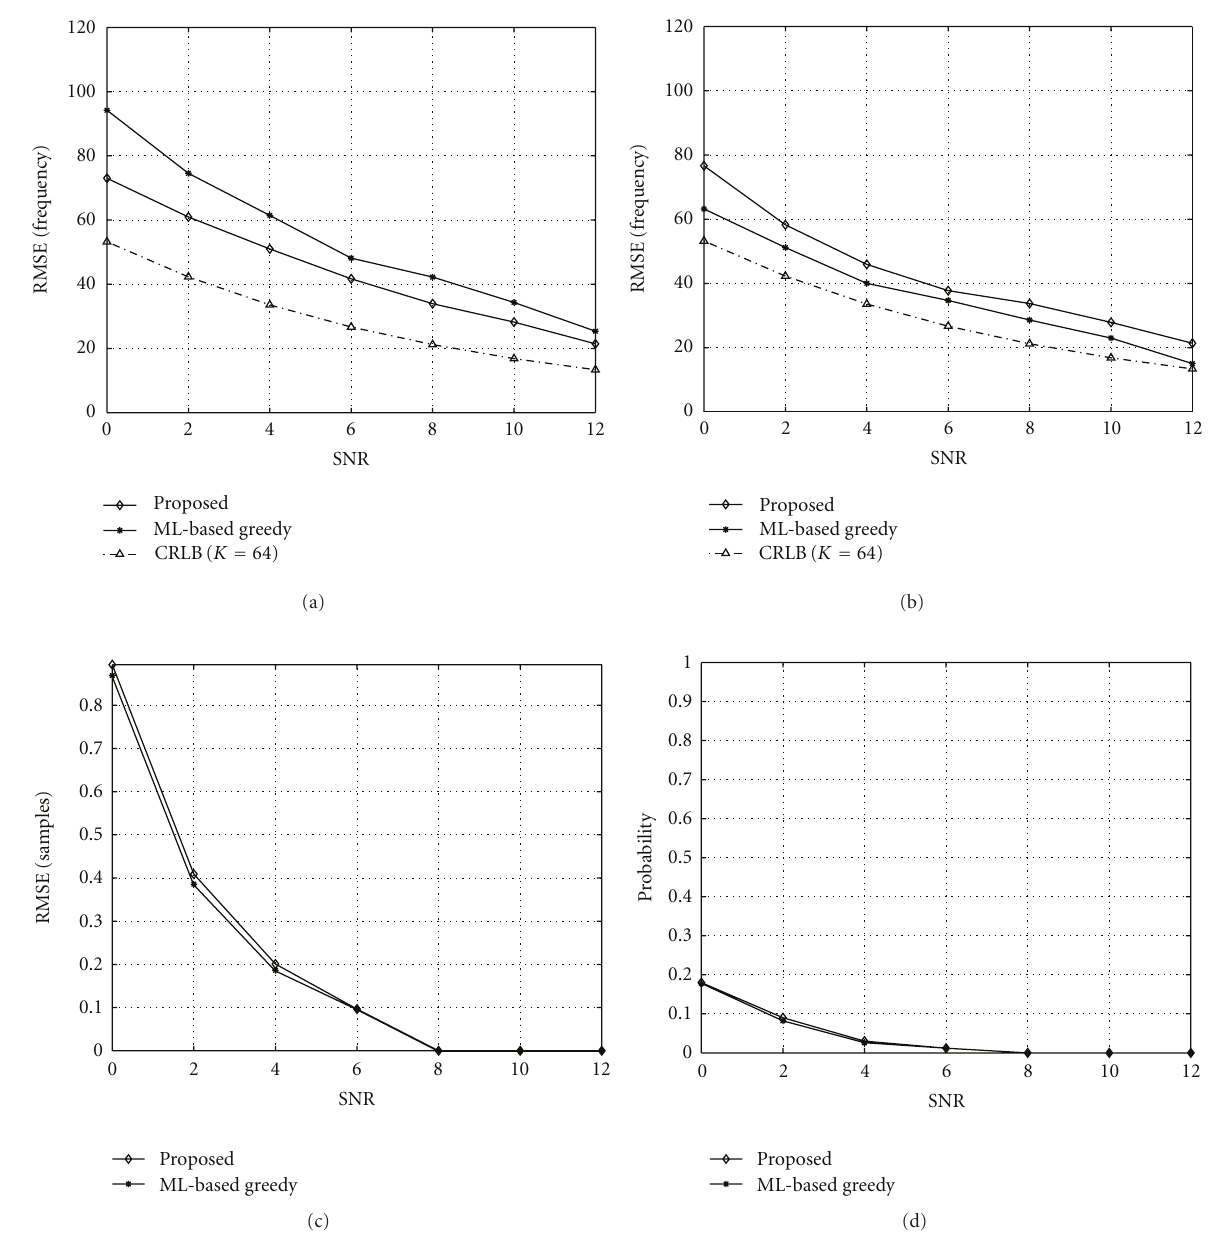
Figure 4: Root mean square estimation error versus SNR with K = 56. (a) RMSE of f 1 estimate, (b) RMSE of f 2 estimate, (c) RMSE of K estimate, and (d) error probability of K